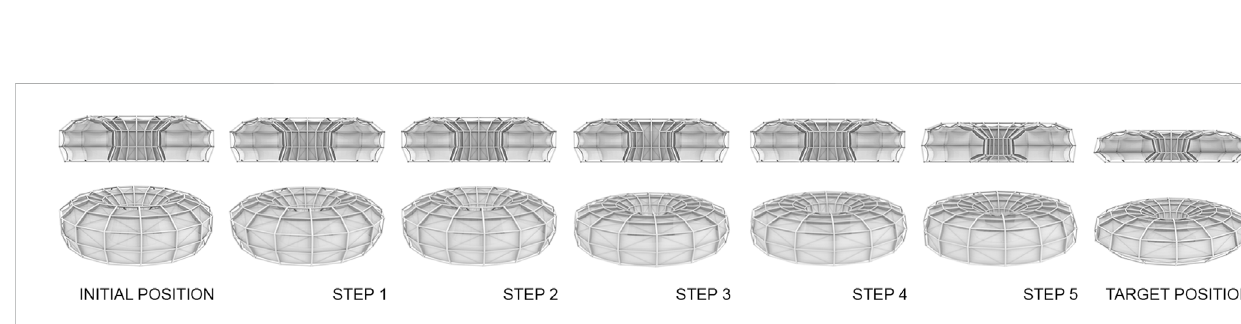
FIGURE 6 Building sections and isometric views of the transformation steps based on the ECS approach.